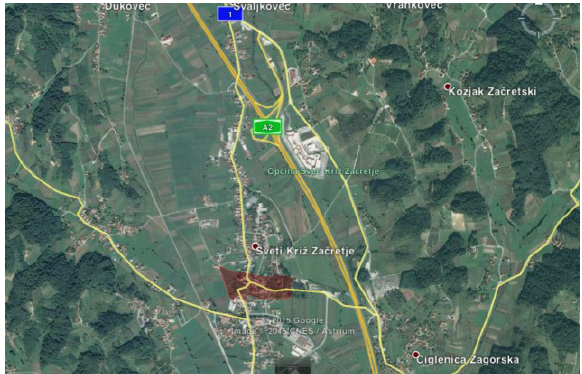
Figure 2. Sveti Križ Začretje